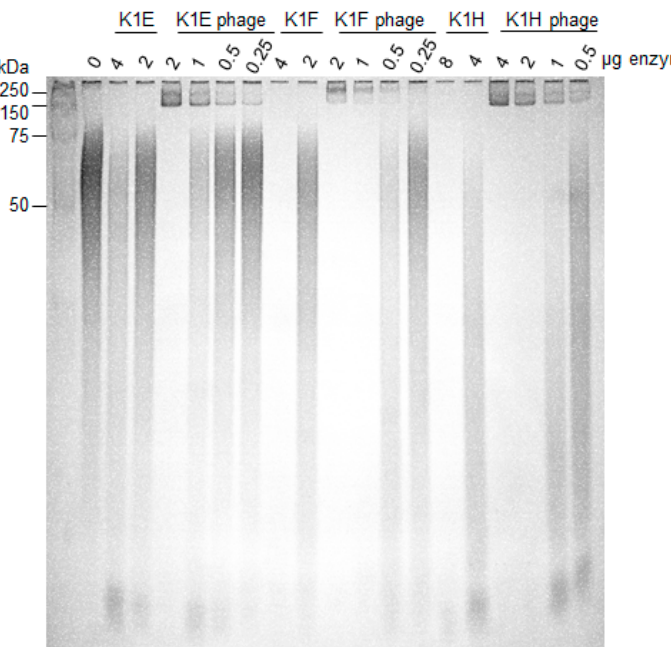
Figure 3. In vitro activity comparison of depolymerases and cognate phages. 10–20 μ g of K1 capsule were incubated with serial dilutions of K1E, K1F, K1H depolymerase or phages at the indicated amount of enzyme equivalents (0.25–8 μ g). Active enzyme is indicated by loss of signal within the lane; enzyme associated with phages is 4–8 fold more active than free enzyme. Incubation was at 37 ◦ C for 1 h; reactions were fractionated using 12% TBE-PAGE with Alcian Blue staining. Protein standards were loaded in the leftmost lane and their molecular weights indicated.